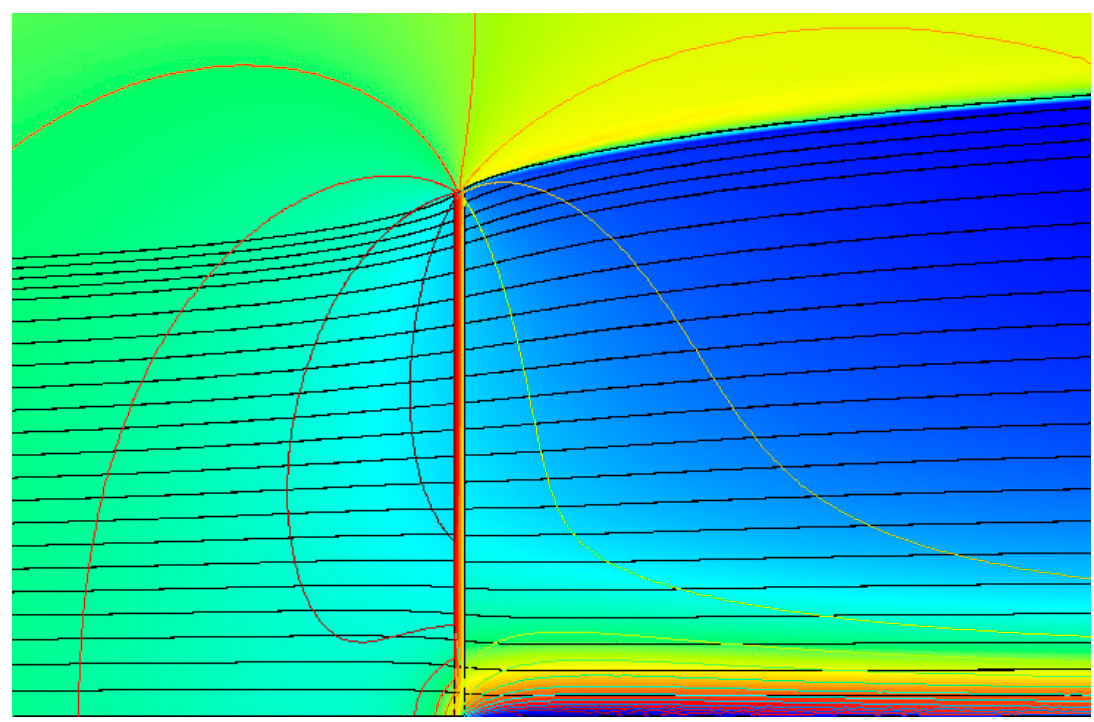
Figure A5. Step 4 zoom-in on solution around disk. Example for λ = 5, C t − blade = 0.914. Surface coloring indicates velocity magnitude, line contours indicate pressure isobars.